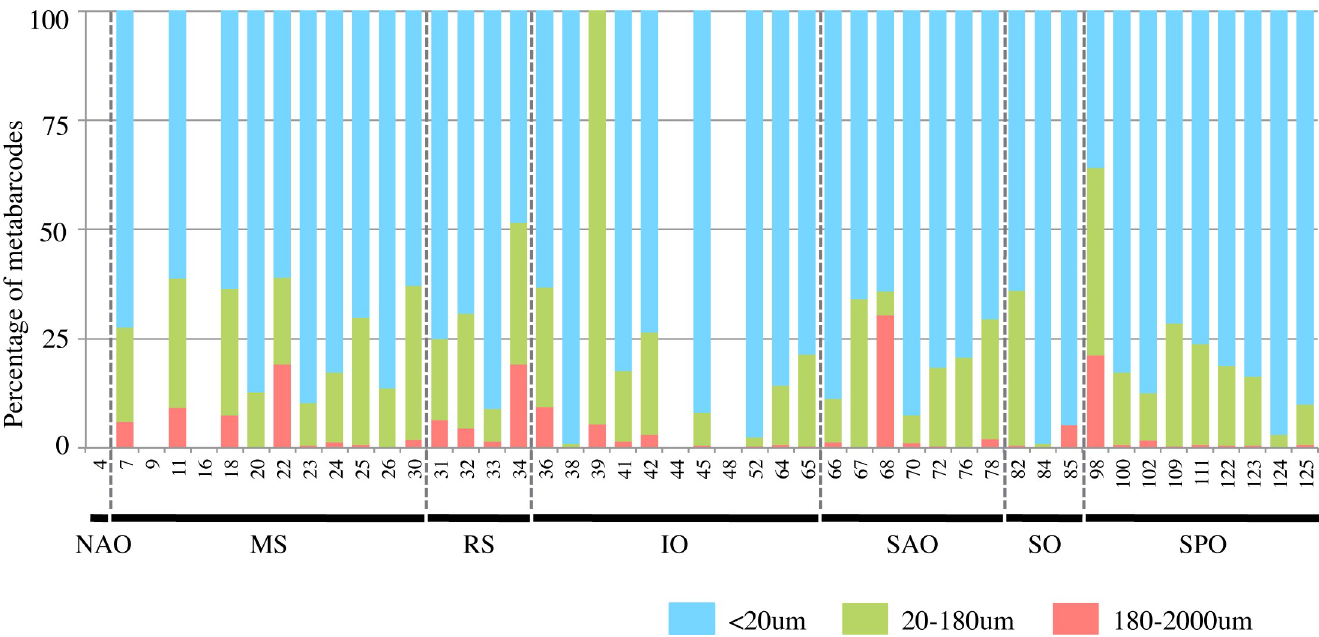
Fig 10. Relative contribution of aplanochytrids in each size fraction of Tara Oceans data set. Ratio of number of sequences in three size fractions (blue: < 20 μ m, green: 20–180 μ m, red: 180–2000 μ m) at each sampling site. Note: filter with 200 μ m pore size instead of 180 μ m was used only at station 82. NAO: North Atlantic Ocean, MS: Mediterranean Sea, RS: Red Sea, IO: Indian Ocean, SAO: South Atlantic Ocean, SO: Southern Ocean, SPO: South Pacific Ocean.